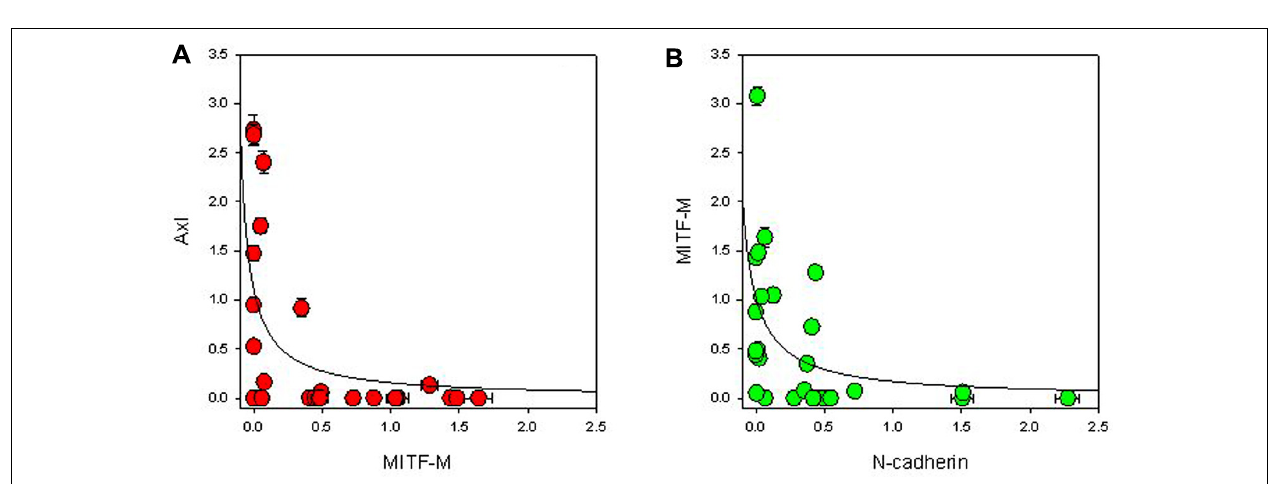
collection; Mel indicates data for normal melanocytes.The western blot shown is representative of three independent repeats. (B) Western blot quantification of MITF-M and Axl as ratios to β -actin loading controls. Bars show SEM.